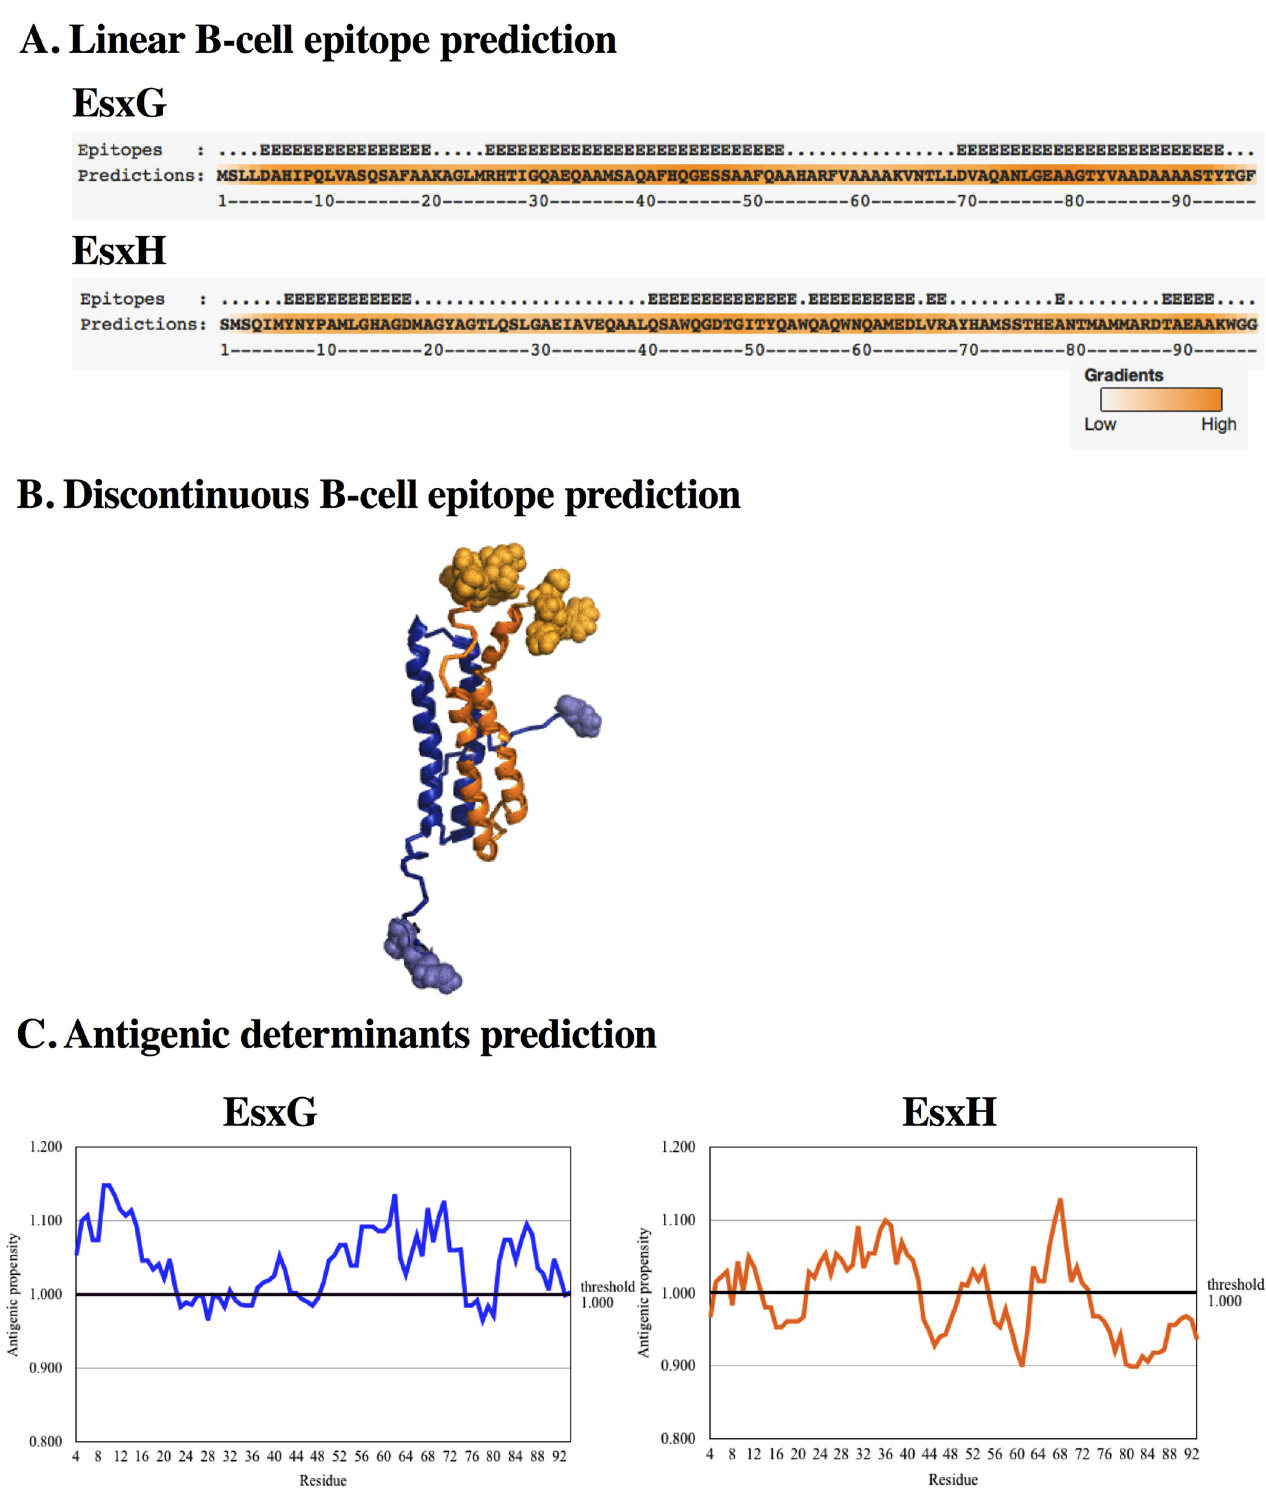
Fig 2. Epitope prediction. (A). Linear B cell epitope prediction. Prediction in BepiPred 2.0. Residues that present a score higher than 0.46 are indicated with an E at the top of the sequence. Residues with values greater than 0.46 are colored in dark orange. (B). Discontinuous B cell epitope prediction. Prediction in DiscoTope 2.0. Epitopes predicted are shown as spheres. (C). Antigenic determinant prediction. Kolaskar and Tongaonkar´s prediction method was employed; x-axis—residue number; y-axis—antigenic propensity. Residues with antigenic propensity greater than 1.000 were predicted as potential antigenic sites.